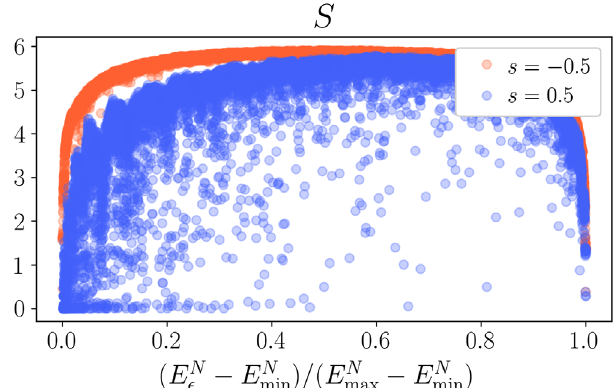
FIG. 7. Entanglement entropy and local occupation as a function of the position on the chain. For several eigenstates, both quantities decay exponentially with the distance to the left edge. The labels in the entropy plot indicate the indices of (some of) the eigenvectors ordered by increasing energy. Colors indicate the energy of the eigenstates from purple (low energy) to red (high energy). The figures show data for s ¼ 0 . 5 and N ¼ 15